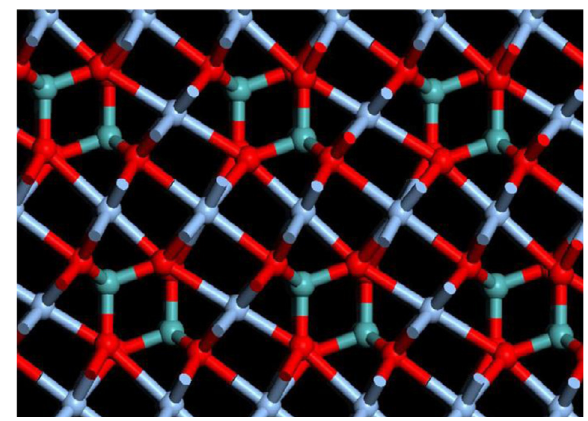
Figure 7. Diagram depicting the structure for Ag 2 MoO 4 . The blue, green, and red spheres represent Ag, Mo, and O, respectively